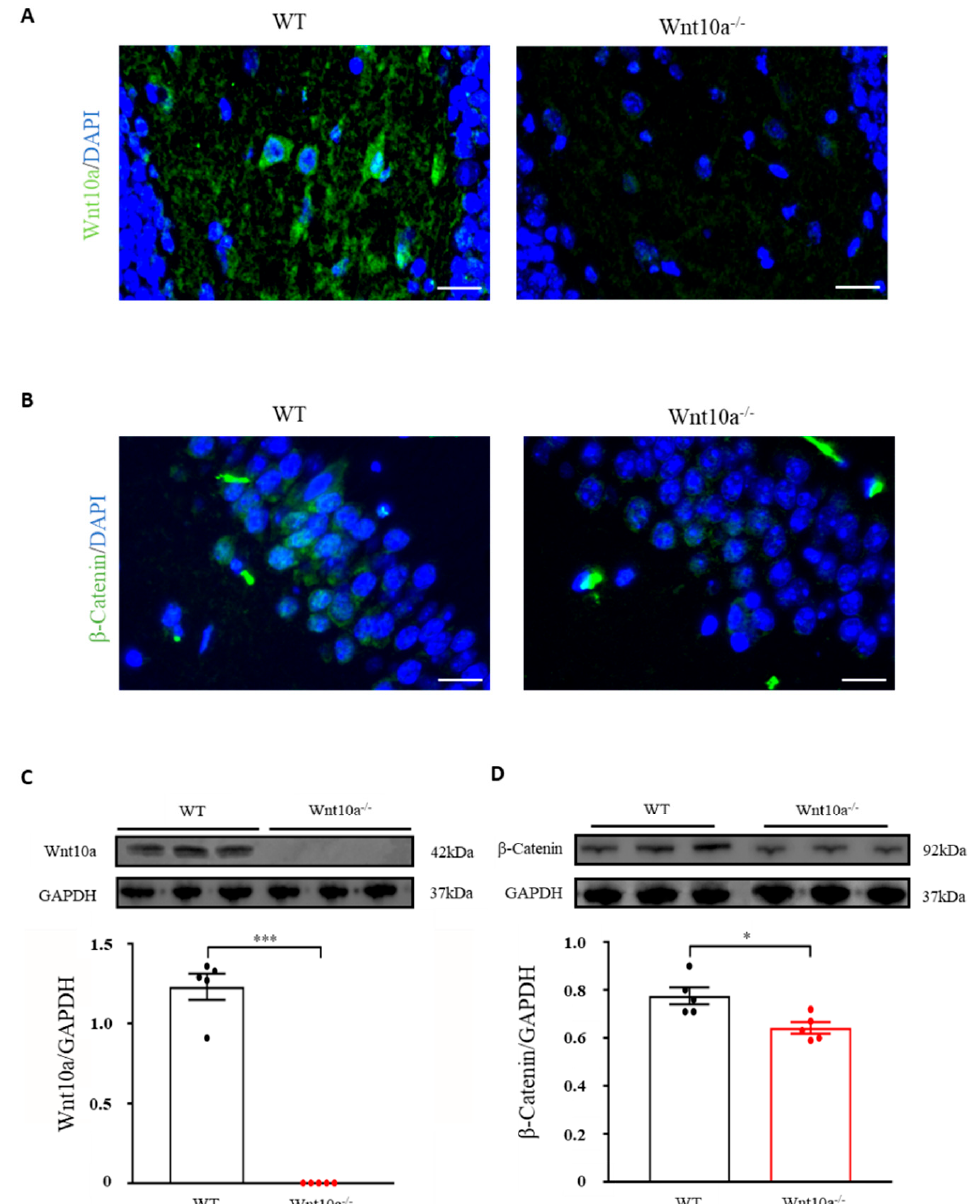
Figure 3. Immunofluorescence images and protein expressions of Wnt10a and β -catenin in the hippocampus. Wnt10a-positive cells were present in the hippocampi of WT mice. There no Wnt10a- positive cells in Wnt10a -/- mice ( A ). The protein expression of Wnt10a was not detected in Wnt10a -/- mouse hippocampi ( C ). Compared with WT mice, β -catenin-positive cells and protein expression were significantly decreased in Wnt10a -/- mouse hippocampi ( B , D ). Scale bars = 20 µ m in ( A ) and ( B ); data are expressed as mean ± SEM; n = 5/group; * p < 0.05 and *** p < 0.001.